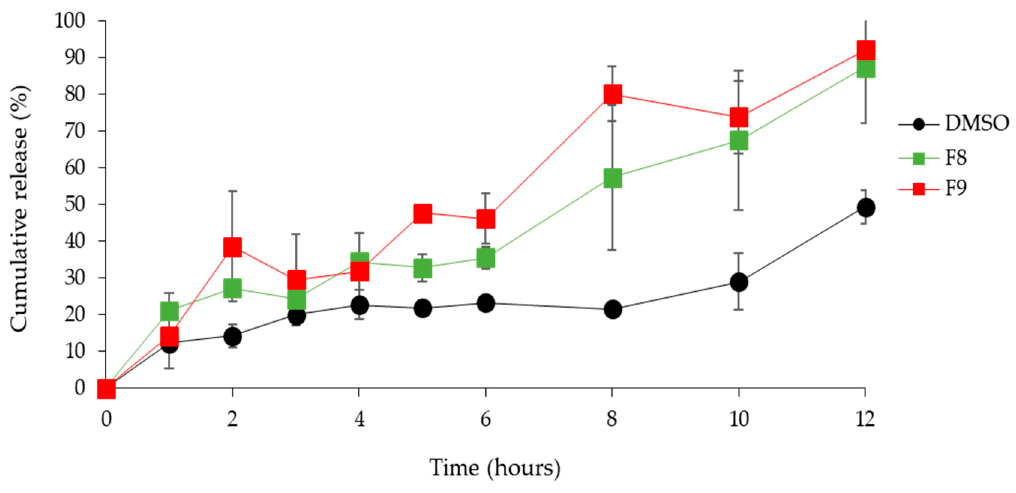
Figure 4. KY19382 transdermal permeation profiles obtained after application of different mixed micellar formations or KY19382 in DMSO to artificial skin. Formulation details are presented in Table 2. Data are presented as the mean ± standard deviation (SD).